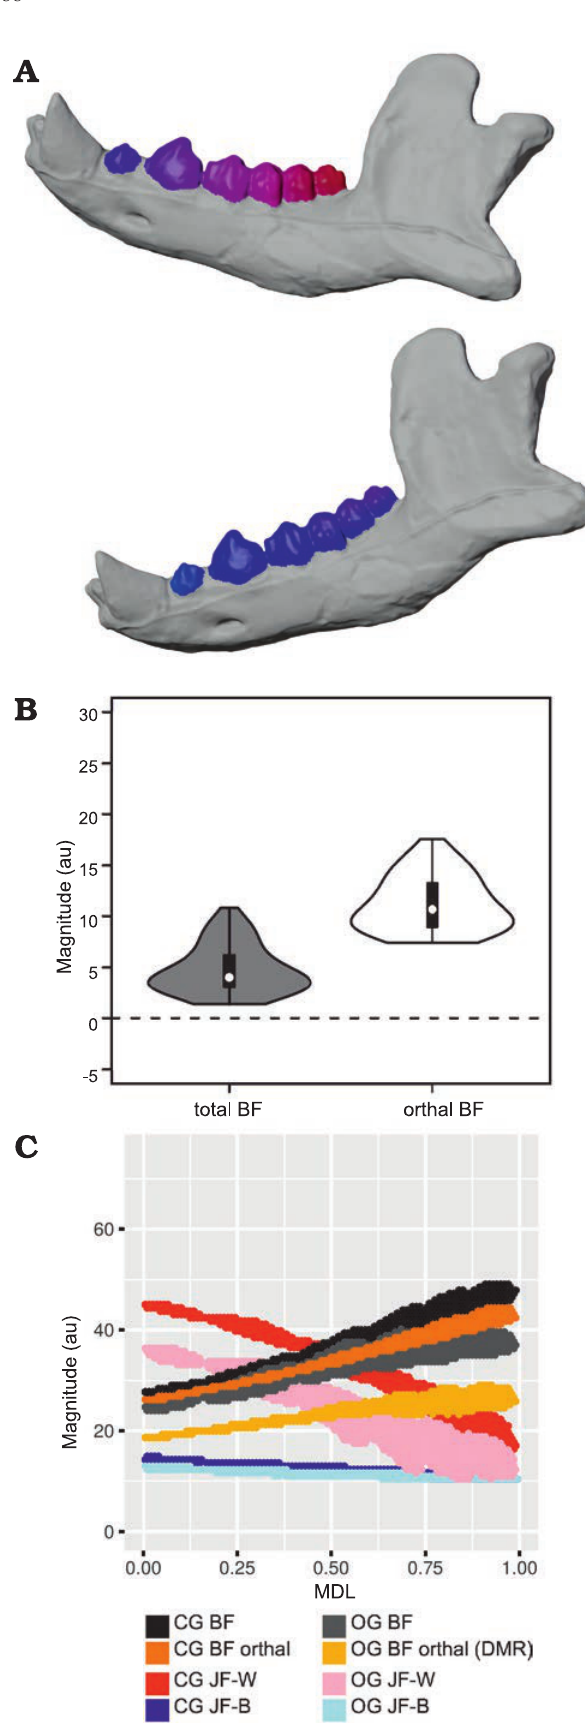
Fig. 6. Results of closed gape minus open gape analysis of orthal bite force (BF) for Peligrotherium tropicalis Bonaparte, Van Valen, and Kramarz, 1993. A . Lower left working-side hemimandible of P. tropicalis shown in closed gape (CG) and open gape (OG) position, postcanine crown surfaces are colorized by relative orthal BF (warmer colors represent higher rela- tive orthal BF, and correspond among the taxa seen in Fig. 12). B . Violin boxplot showing distribution of total CG minus OG BF and its orthal com- ponent marginal over all locations in the woking-side postcanine tooth- row. C . 2D histogram plot showing distribution of estimated bifulcral force magnitudes for CG and OG, as a function of mesiodistal location (MDL). JF-W/B, working-/balancing-side joint